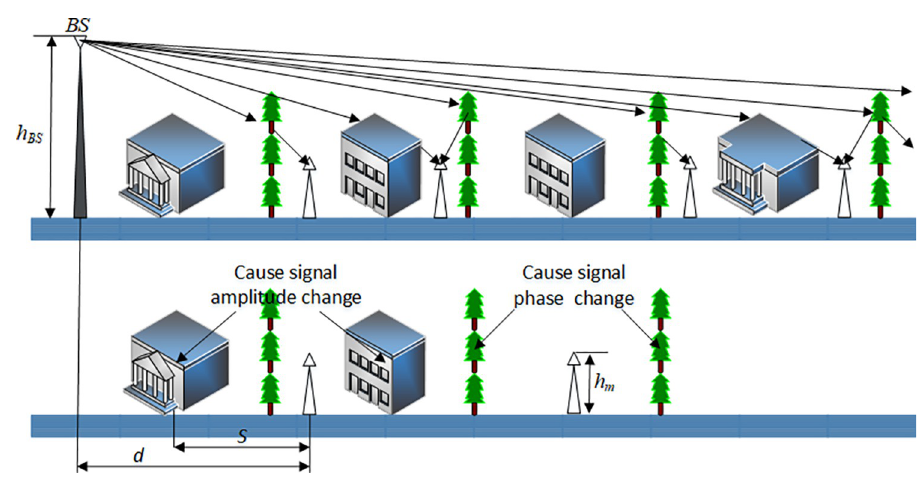
Fig 4. Electromagnetic wave propagation path with trees and buildings arranged in